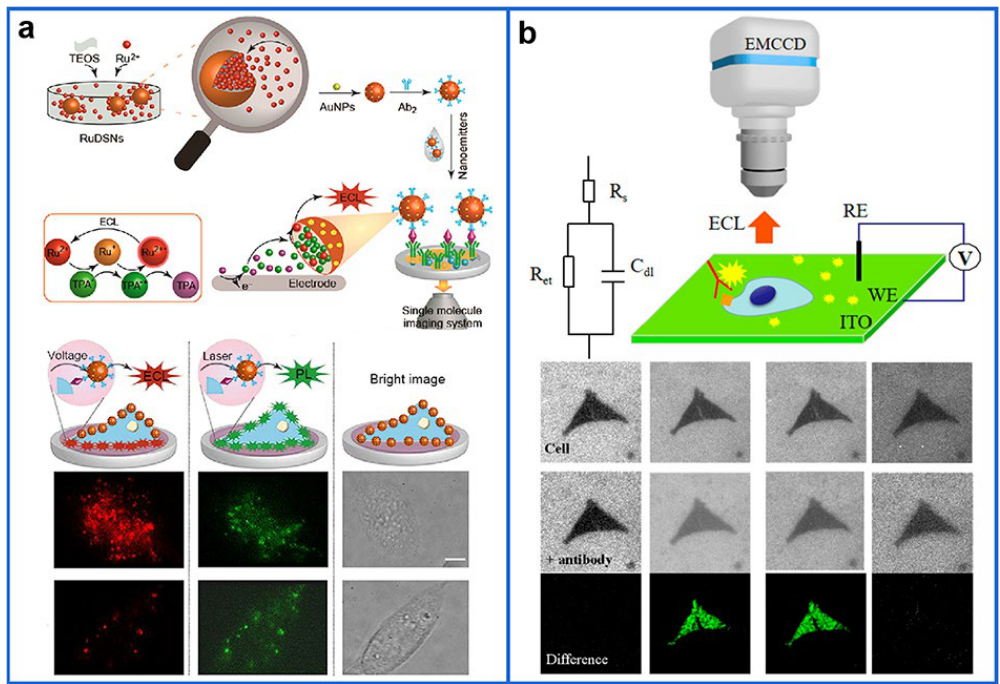
Figure 2. ( a ) Schematic illustration for single-protein molecule imaging by ECL. ( b ) Schematic diagram of the label-free electrochemiluminescence-based capacitance microscopy for imaging of antigens on the cellular plasma membrane. Reprinted with permission from [117,124]. Copyright 2021 and 2019, American Chemical Society.